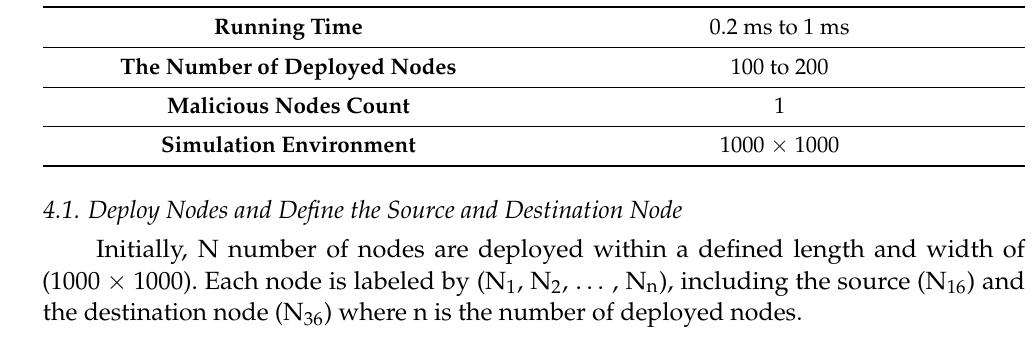
Table 2. Simulation Parameter.